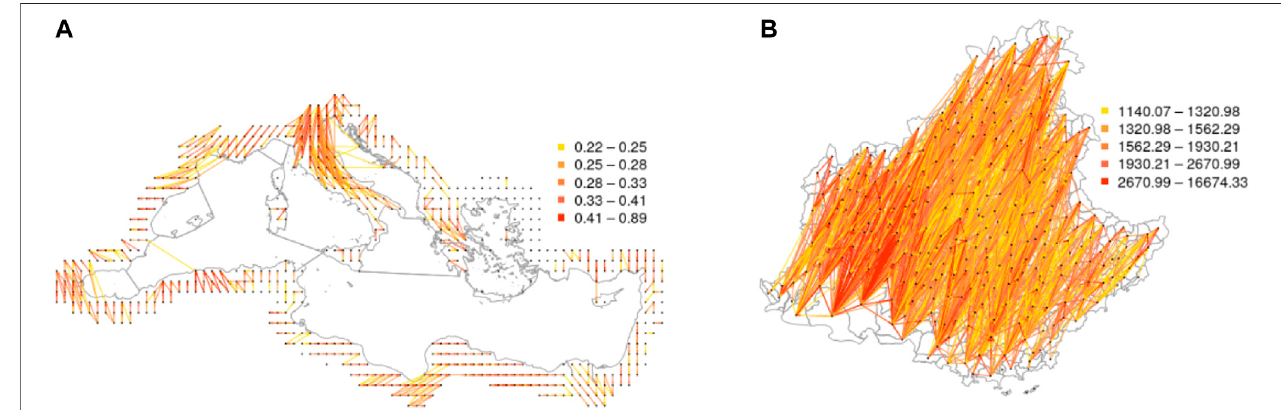
FIGURE 4 | Networks weighted by contact-based connectivities generated by air mass trajectories: The connectivities are generated by air mass trajectories between (A) the604 sampled circular areas withintheMediterranean basin and (B) the294watersheds ofPACA. Edgeswith weights lower than0.3 for (A) and 2 × 10 3 for (B) are not drawn. The cuts of the intervals in the two legends are chosen in such a way that each interval contains 20% of the observed data. The differences in the valuestakenbytheconnectivitiesin (A) and (B) areduetodifferentmeasuresofthearea | B | in Eqs.11 , 12 : | B | (cid:1) 1foreachnodein (A) ,whereas B istheactualarea (expressed in km 2 ) of each whatershed in (B)